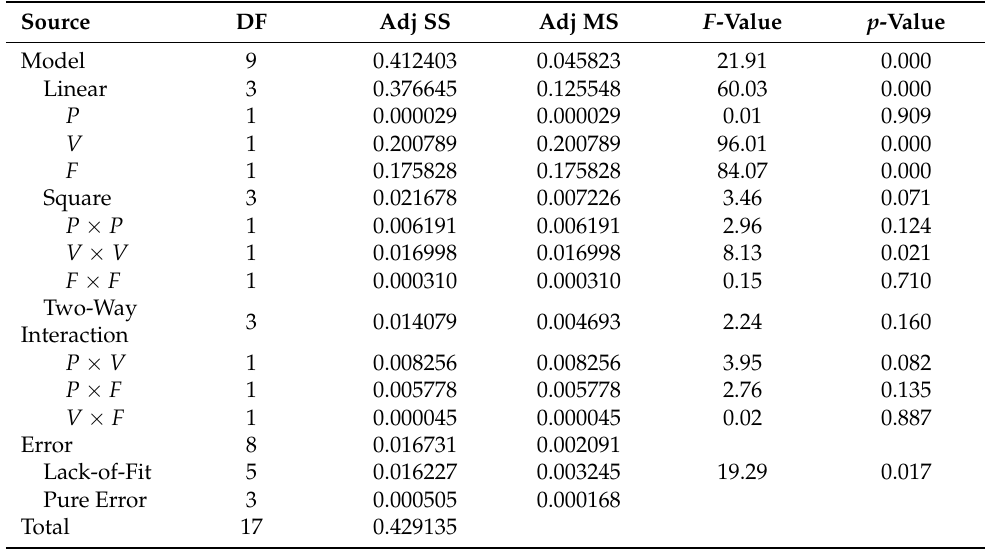
Figure 5. Effect of LEL and PFL on H . An ANOVA is performed to statistically examine the relative significance of the LDED- PF process parameters on H as presented in Table 4. V and F are the most significant process parameters influencing the track height, while P has a lower effect. The contributions of V and F towards H are 47.6% and 40%, respectively. The Pareto chart presented in Figure 6 also shows that V and F are the most significant parameters in determining the H of the Fe20Cr5.5AlY deposits. The response model of the H is shown in Equation (5). The R 2 of 0.96 indicates a good correlation between the experimental values and predicted values, and the model’s significance is indicated by the p value < 0.05. It can be concluded that the model is significant with a 97.6% contribution towards explaining the behavior of H . Table 4. ANOVA analysis of H .